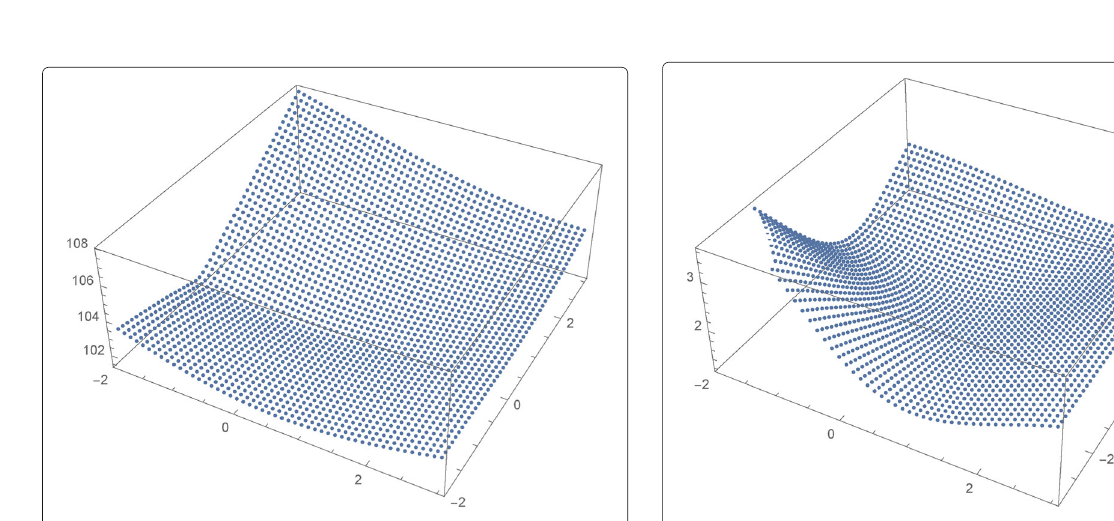
Fig. 9 Expectation value of the procurement cost E [ C ]